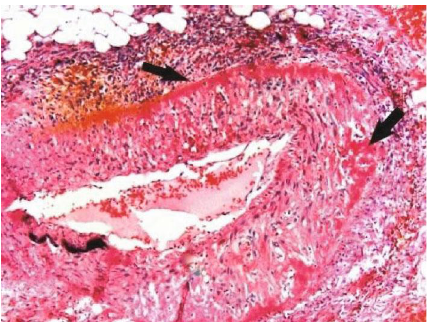
Figure 1: Segmental arterial mediolysis injurious phase with a vasospastic appearance. The top arrow points to the adventitial medial junction circumscribed by a thick linear band of fi brin that at lower arrow extends into and focally fi lls and obscures areas of mediolysis of the outer half of the media. Hematoxylin & eosin × 50 (adapted from the WJCD 2013.3 published online).